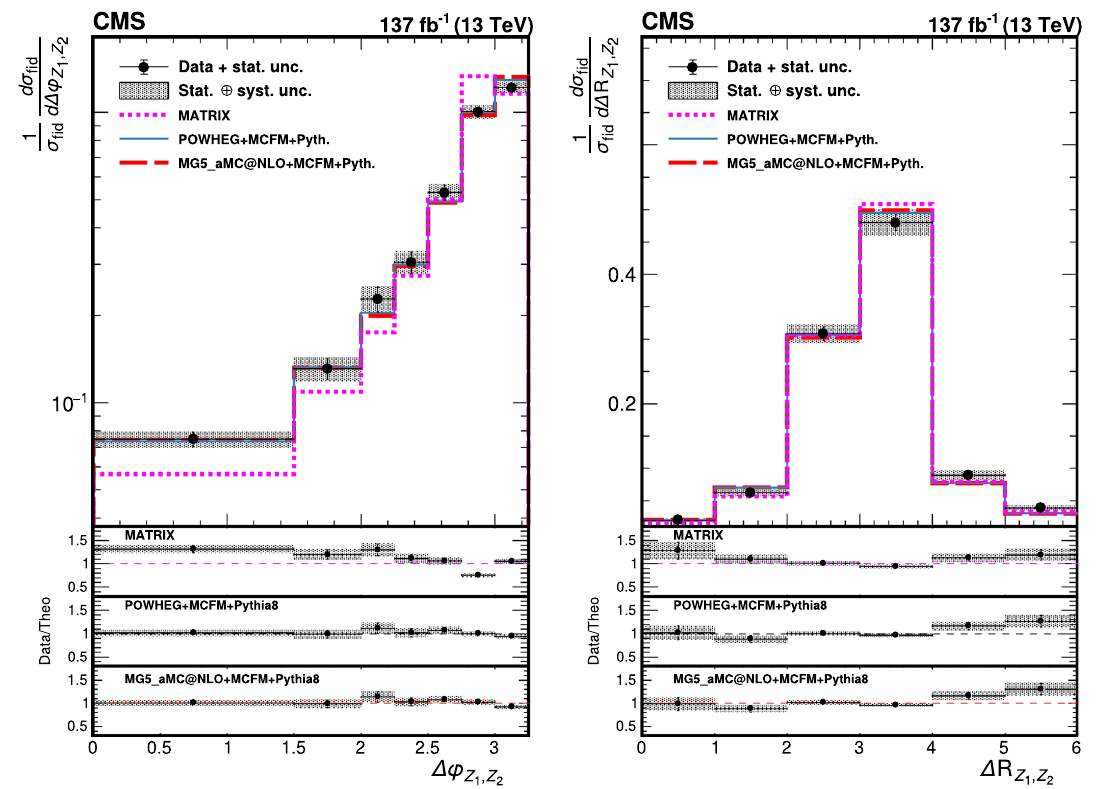
Fig. 6 Differential cross sections normalized to the fiducial cross sec- tion for the combined 4e, 2e2 μ , and 4 μ decay channels as a func- tion of the azimuthal (left) and Δ R (right) separation of the two Z bosons. The points represent the unfolded data with error bars showing the statistical uncertainties, the shaded histogram the powheg + mcfm ZZ predictions, and the dashed curves correspond to the results of the Matrix and MadGraph 5_a mc@nlo + mcfm calculations. The Fig. 7 Distribution of the reconstructed ZZ mass for the combined 4e, 2e2 μ , and 4 μ channels. Points represent the data with error bars showing the statistical uncertainties, the shaded histograms represent the SM prediction including signal and irreducible background from simulation, and the reducible background estimate from data. Dashed histogram represents an example of the aTGC signal. The last bin includes contribution from all events with mass above